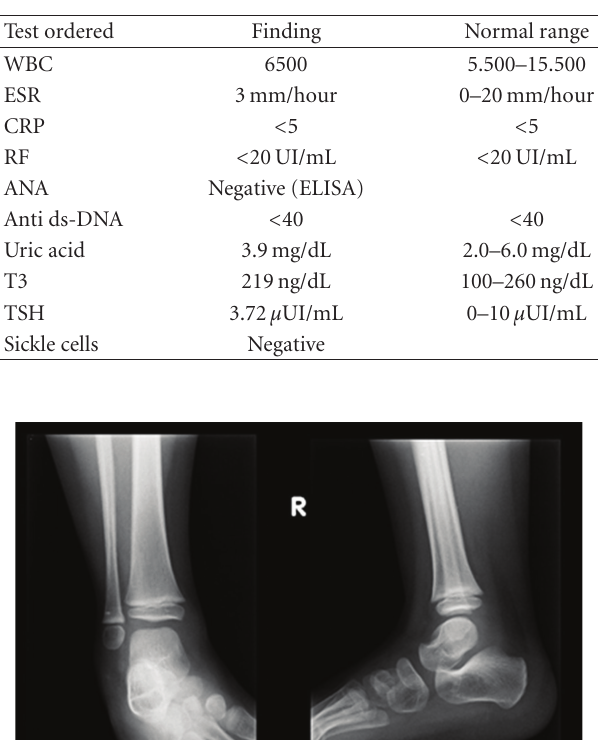
Table 1: Laboratory findings.